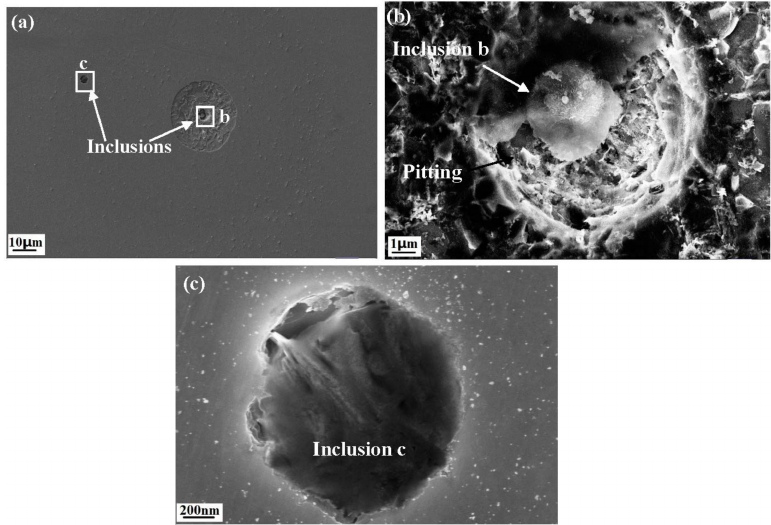
Figure 1. Corrosion morphology of the X70 steel after 5 min immersion in 0.5 mol/L NaCl solution: ( a ) overall morphology; local morphology of ( b ) inclusion b and ( c ) inclusion c. Table 2. Element percentages of the inclusions in Figure 1, obtained by EDS.